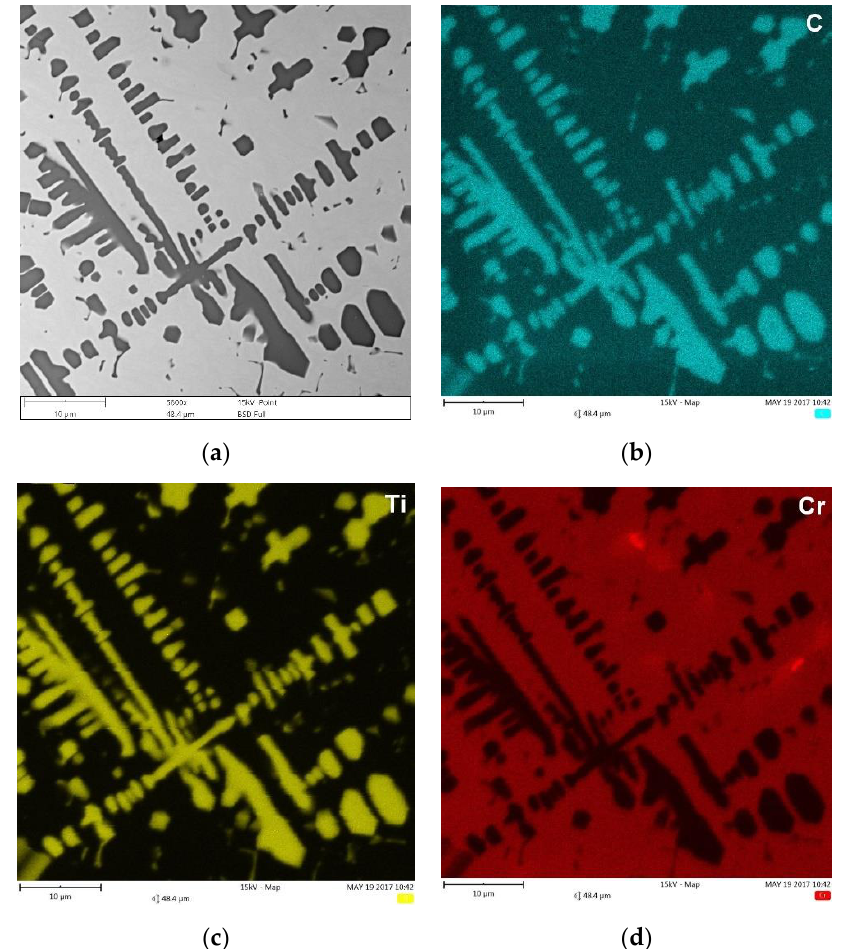
Figure 11. ( a ) BSE SEM micrograph taken from the mid-section of TRC (Table 3) showing the primary TiC precipitates in dendritic form and eutectic plate-like TiC precipitates, and ( b – d ) corresponding maps of C, Ti, and Cr distribution, respectively.